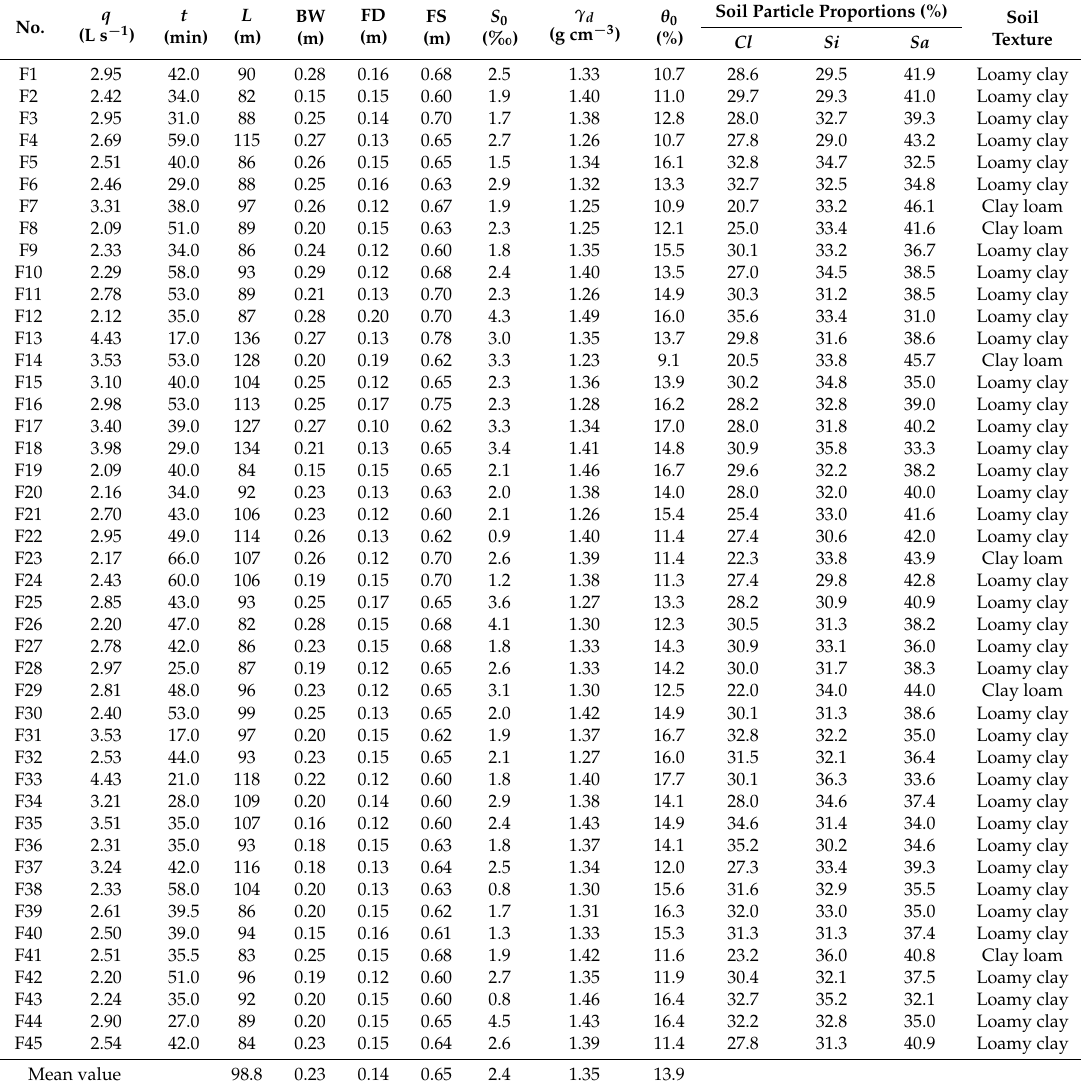
Figure 1. Map of study area and experimental layout of closed-end furrow irrigation. Notes: ■ represents the study area. ● represents an experimental site. Table 1. Details of the closed-end furrow irrigation experiments.